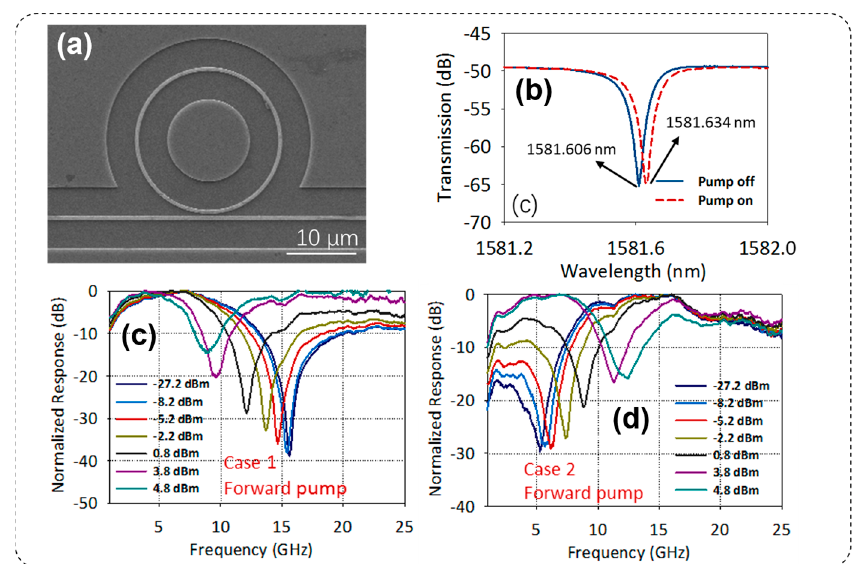
Figure 18. Implemented all-optical tunable notch MPF proposed in [108]: ( a ) SEM image and ( b ) measured transmission spectrum of the fabricated MRR with the pump light off and on, ( c , d ) measured microwave responses of the tunable MPF under different pump powers. Courtesy of and adapted from Jian Wang [108].